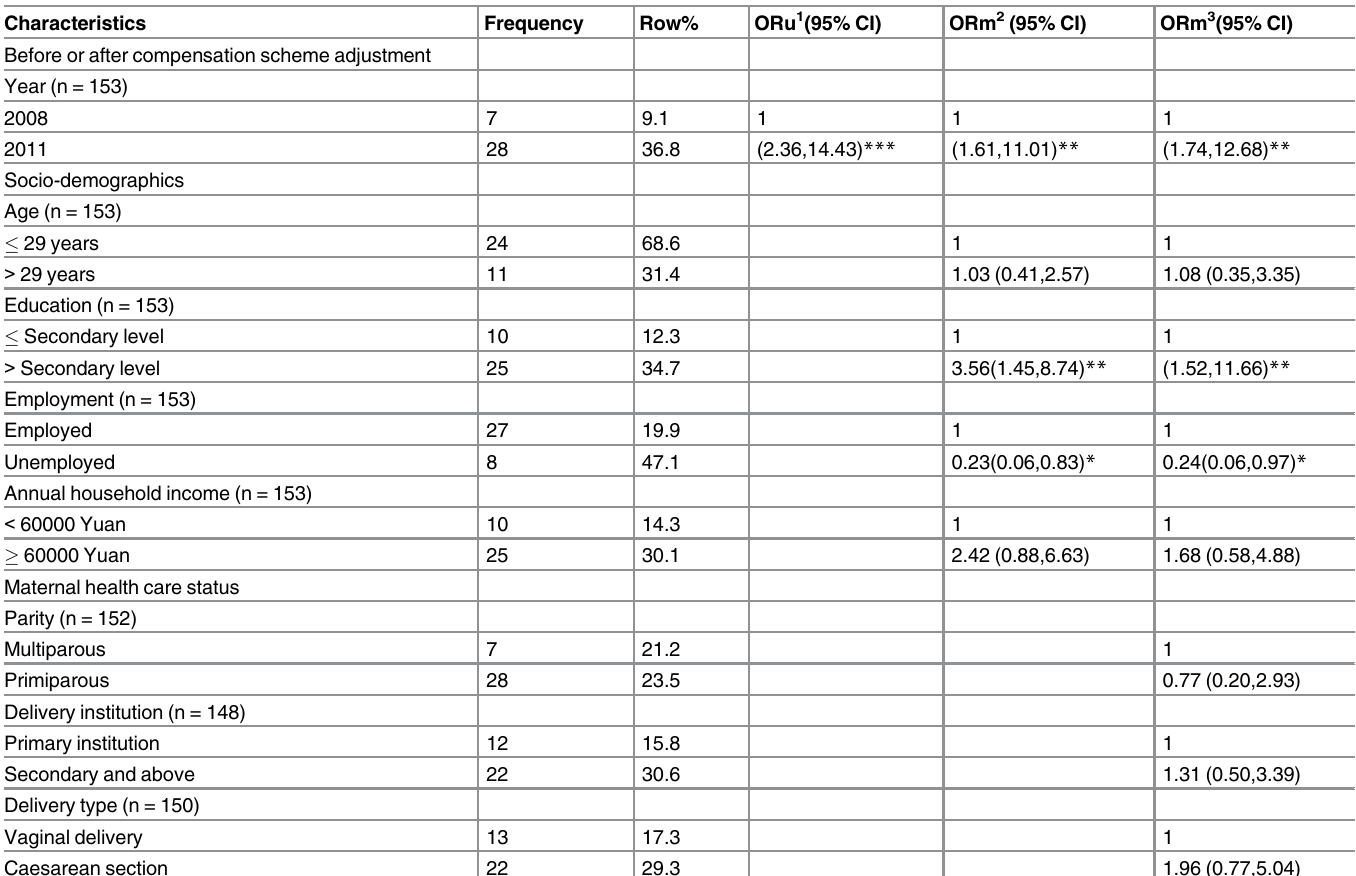
Table 3. OR and 95% CI for reimbursement.